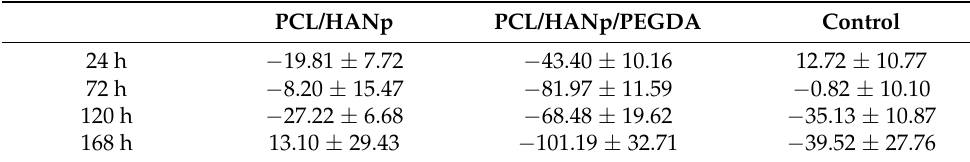
Table 6. Percentage of viability inhibition evaluated by PrestoBlue ® viability assay for hDPSCs after 24, 72, 120 and 168 h. Results presented in mean ±